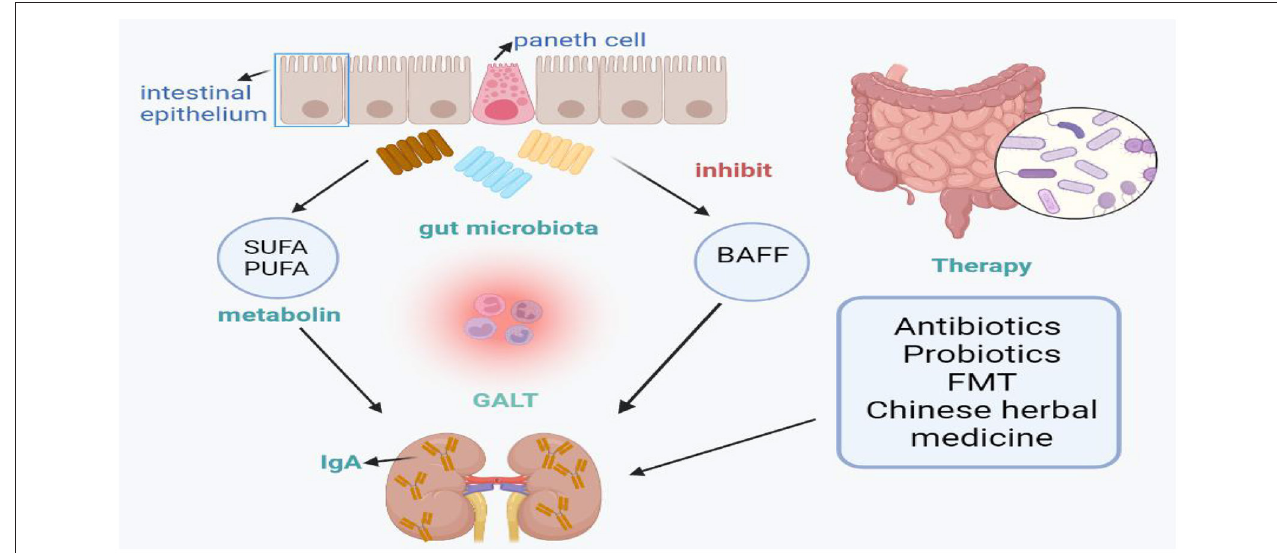
FIGURE 1 | Microbiota and associated metabolites involved into the pathogenesis of